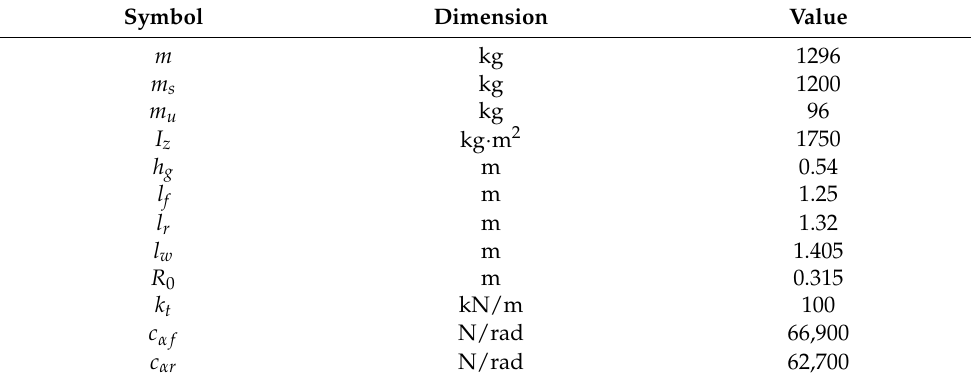
Table 1. Vehicle